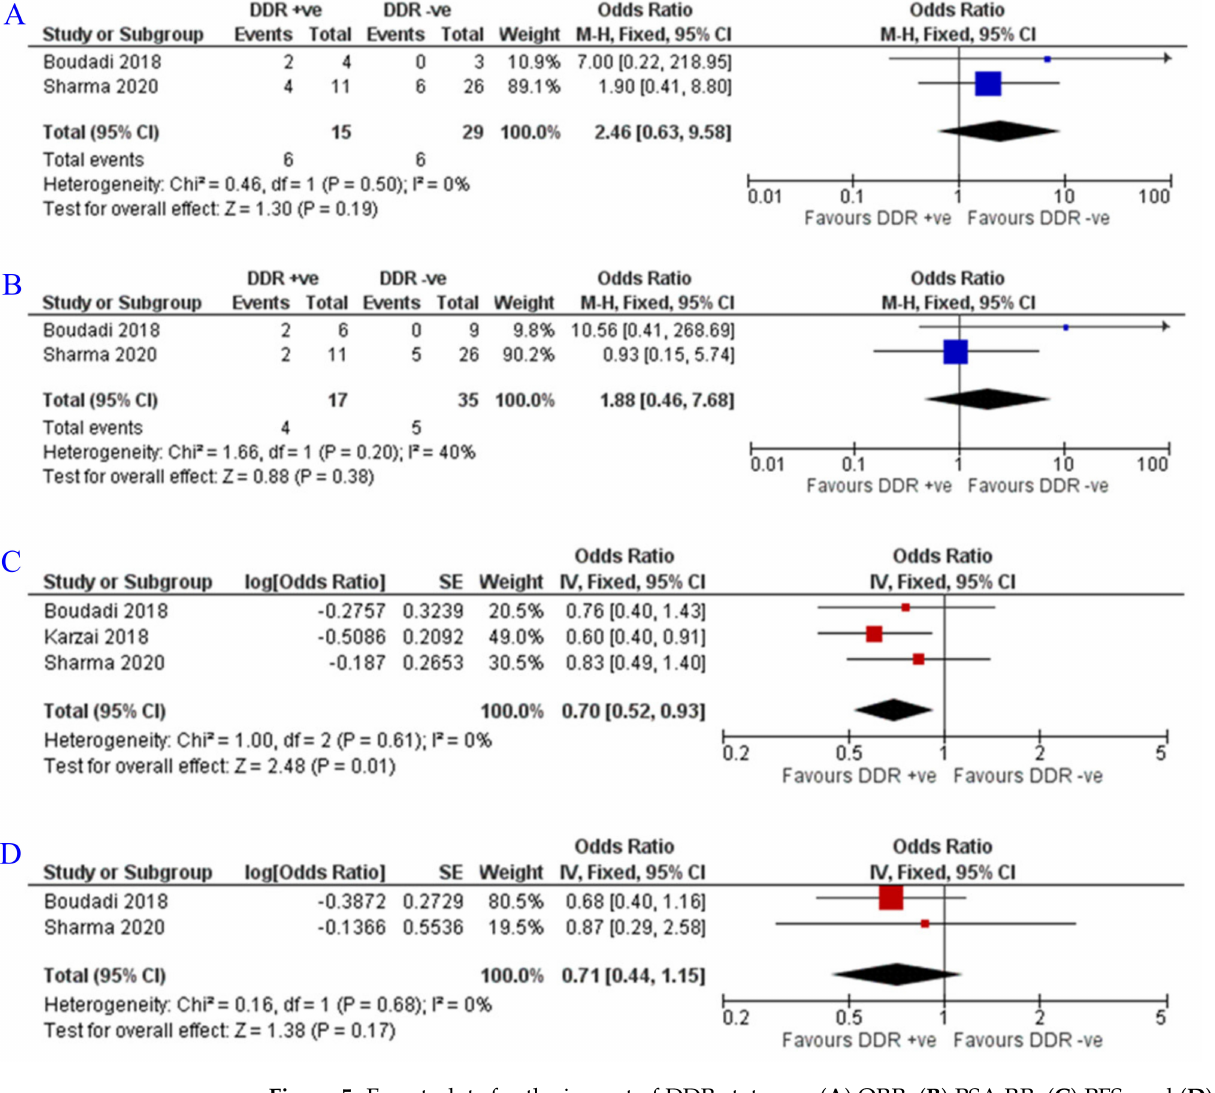
Figure 5. Forest plots for the impact of DDR status on ( A ) ORR, ( B ) PSA RR, ( C ) PFS, and ( D ) OS. DDR, DNA damage repair. Sharma et al., 2020 [19], Boudadi et al., 2018 [20], Karzai et al., 2018 [22].